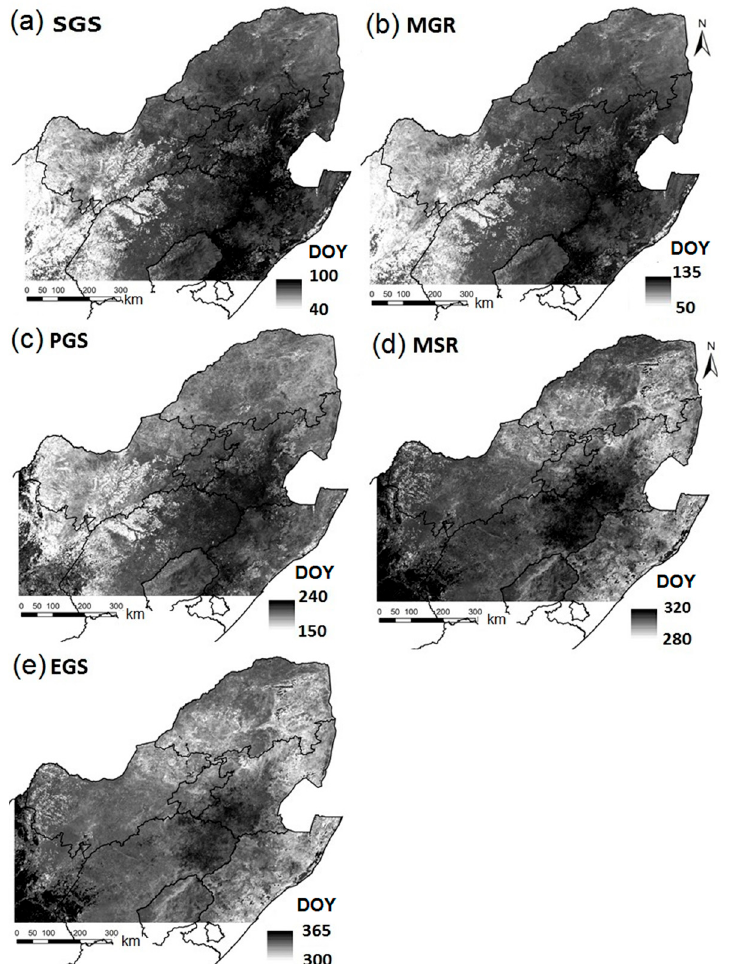
Figure 6. Fourteen-year median maps of the various phenological metrics: ( a – e ) the day of the austral year at start (SGS), maximum growing rate (MGR), peak growth (PGS), maximum senescing rate (MSR) and end of growing season (EGS), respectively. The austral year used in the study ranges from 4 July (Julian Day 185) of one year to 26 June (Day 177) of the following year. Precipitation data of the five meteorological stations (Rustenburg, Marbel Hall, Moosriver, Lephalale, Bloemhof and Escelsior-benchmark) were obtained from the Agricultural Research